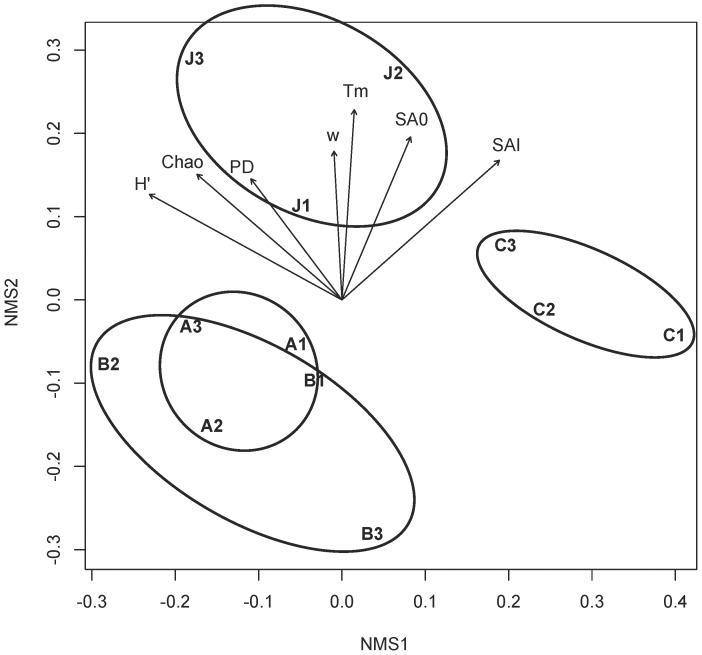
Non-metric multidimensional scaling of phylogeny-based composition of denitrifying communities.The distance matrix was based on pairwise differences in the unique fraction of branches shared (UniFrac) for each soil community replicate in the maximum likelihood phylogentic tree of 400 nosZ gene sequences. Vectors indicate diversity metrics and modeled rate parameters that were significantly correlated with the ordination (P<0.1): Chao richness index, Shannon’s diversity index (H´), phylogenetic diversity (PD), width of the modeled temperature gradient curve (w), denitrifiction rate at temperature optimum (Tm), salt concentration when denitrification rate was zero (SA0) and salt concentration at the initiation of rate inhibition (SAI). Stress was 12.0.